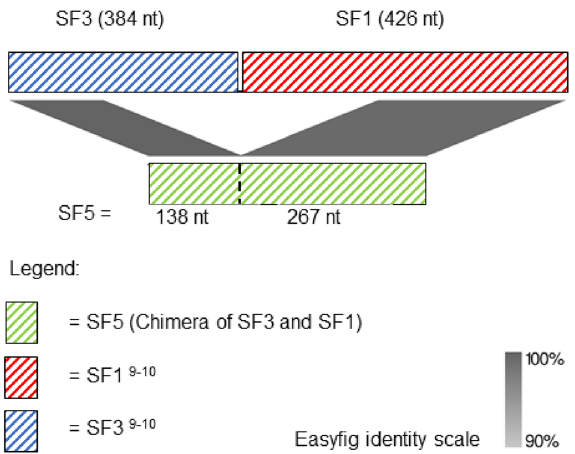
Figure 3. Novel cell wall-spanning domain of group A Streptococcus (GAS) emm , SF5, described by the chimerisation of SF3 and SF1 9,10 . SF3 and SF1 are typical encoded in the majority of enn and a subset of emm , respectively. SF5 was observed in emm 39.4 GAS (31005V6S1) and emm 137.0 GAS